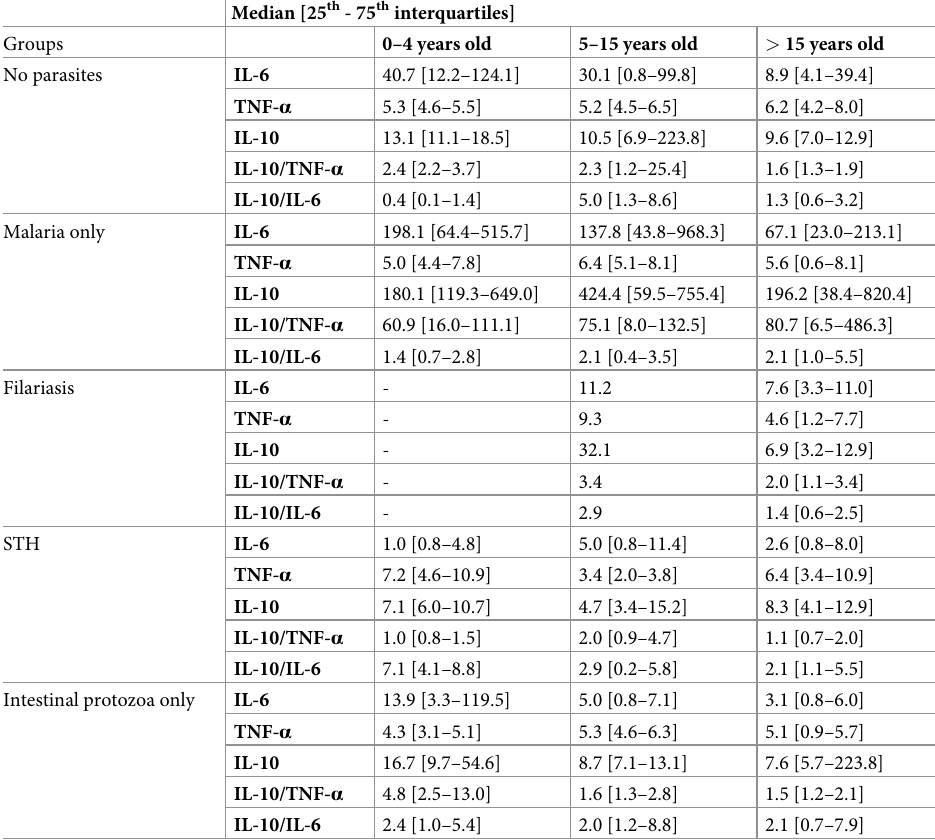
Table 3. Median level of cytokines according to single parasitism and age